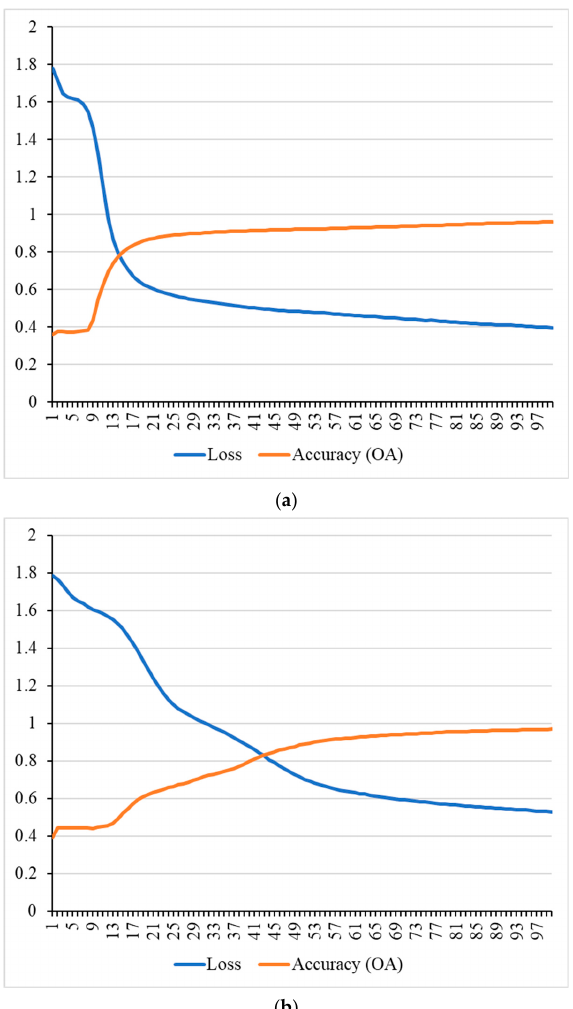
Figure 8. The learning curve of the proposed model with HybridSN backbone model: ( a ) training dataset, ( b ) test dataset.